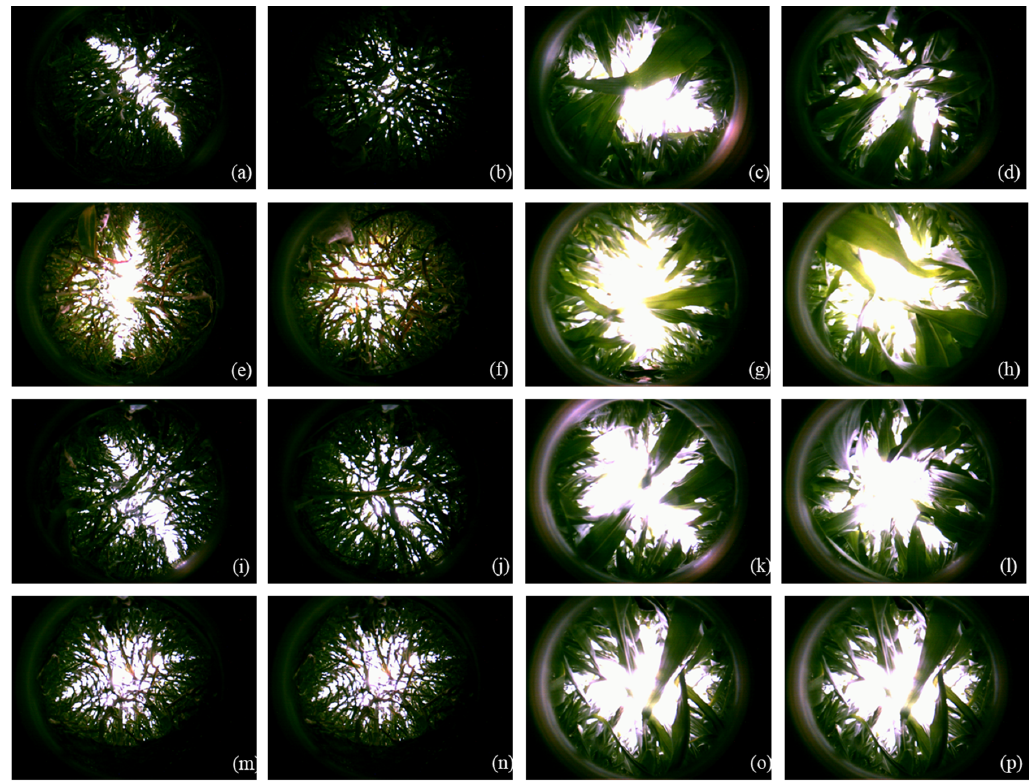
Figure 5. The hemisphere images of ear layer and bottom layer of maize population. ( a – d ) is the optimum mode (OM; CK); ( e – h ) is OM treatment without fertilization (OM ‐ F); ( i – l ) is OM treatment without density (OM ‐ D); ( m – p ) is OM treatment without wide ‐ narrow plant spacing (OM ‐ S; because the uniform row spacing plant, the hemisphere images of wide and narrow row were the same, images ( m , n ); ( o , p )). And ( a , e , i , m ) is wide row bottom layer; ( b , f , j , n ) is narrow row bottom layer; ( c , g , k , o ) is wide row ear layer; ( d , h , l , p ) is narrow row ear layer.